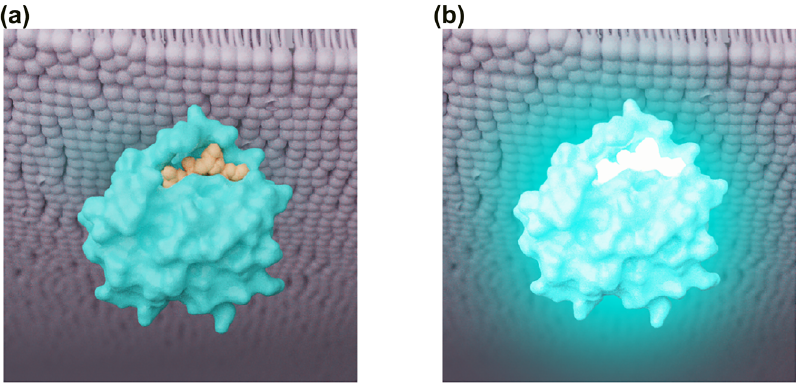
Figure 1: Two color choices and effects to illustrate a molecular reaction between a ligand and its protein receptor. (a) Orange ligand with similar luminance and saturation to its receptor. (b) Ligand and receptor with higher luminance and saturation, with additional highly saturated glow